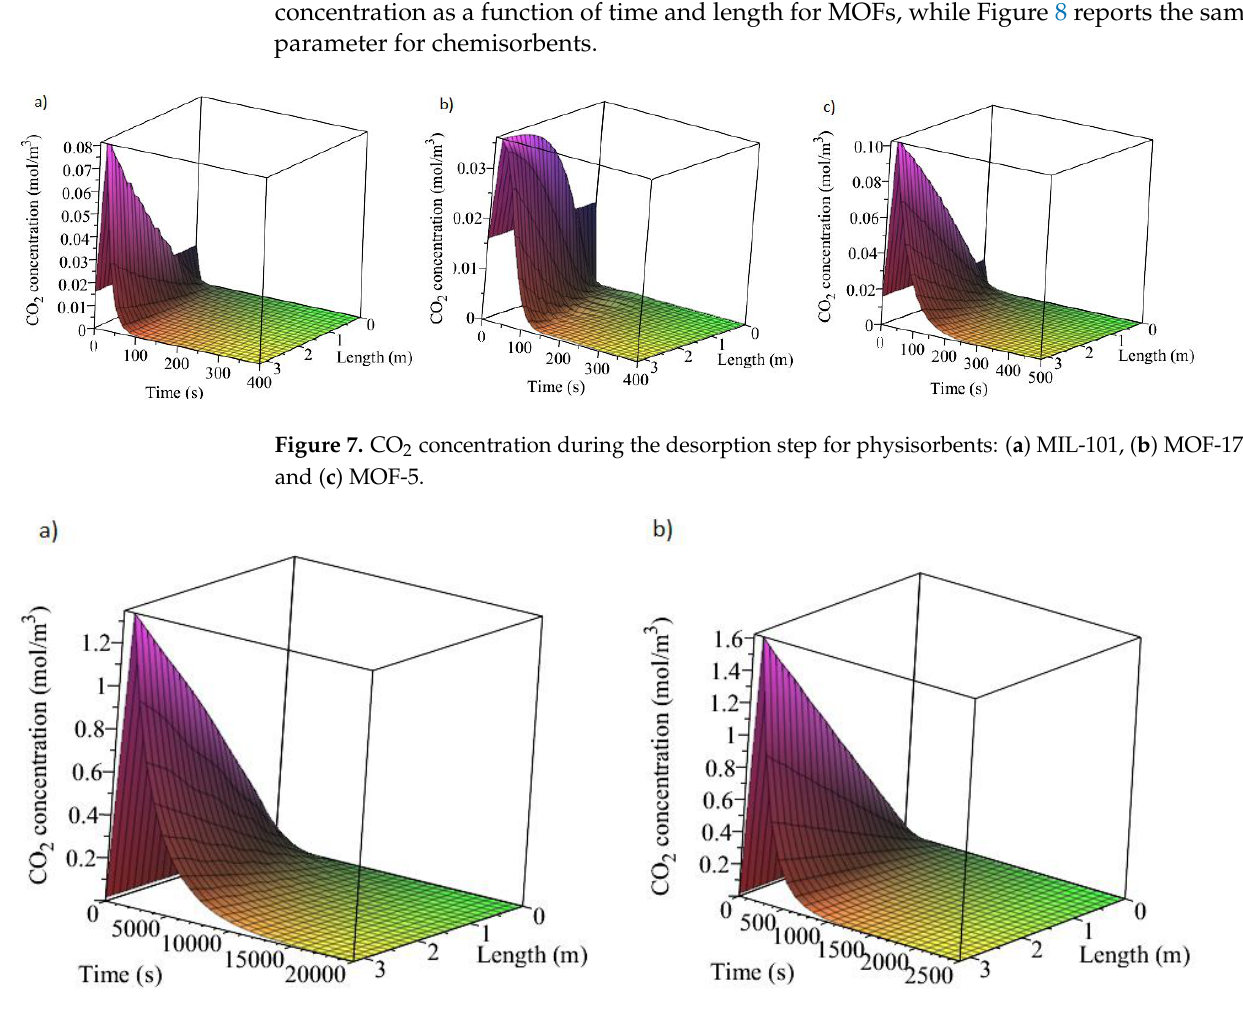
Figure 6 . Loading for chemisorbents: ( a ) SI-AEATPMS sorbent and ( b ) APDES-NFC-FD sorbent . Lower values of equilibrium loading are apparent for MOFs. For MOF-177, MOF-5, and MIL-101 this parameter is, respectively, 0.00043 mol/kg, 0.00093 mol/kg, and 0.00039 mol/kg. On the other hand, for SI-AEATPMS and APDES-NFC-FD the equilibrium load- ing is, respectively, 0.4 mol/kg and 0.85 mol/kg.